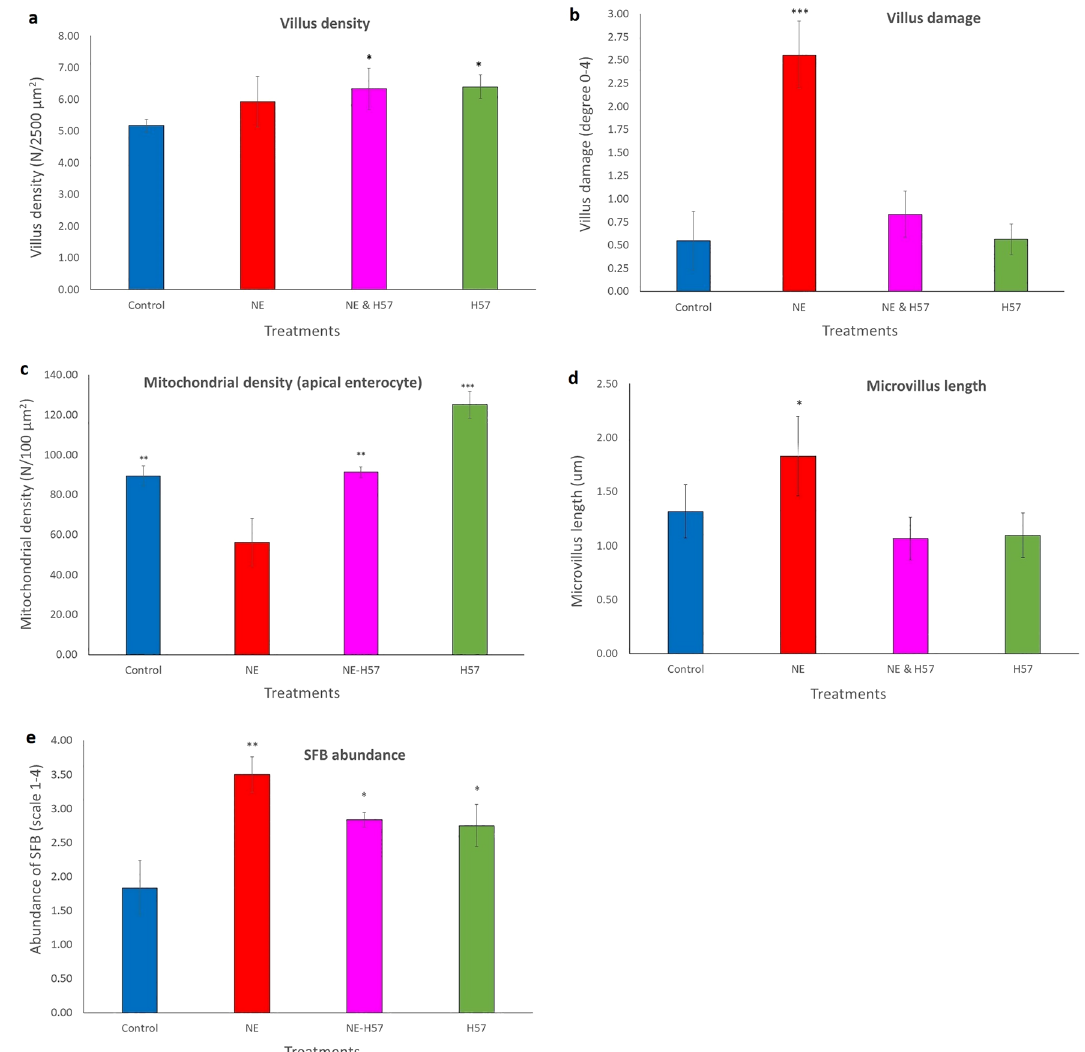
Figure 3. The effect of probiotic H57 on the villus density ( a ) and damage ( b ), SFB abundance ( c ), mitochondrial enterocyte density ( d ), and microvillus length ( e ) from 21 d old chicks exposed to necrotic enteritis. Control chicks were fed a basal diet (not supplemented with the probiotic H57) and not treated with any pathogen; NE chicks received a co-infection with Eimeria vaccine and Clostridium perfringens ( Cp ) and were fed a basal diet not supplemented with the probiotic H57; NE & H57 chicks were exposed to Eimeria vaccine and Cp , and fed a basal diet supplemented with the probiotic H57; H57 chicks were not treated with any pathogen, but fed the control diet supplemented with the probiotic. Error bars indicate SD, while asterisk indicates statistical significance (* p < 0.05; ** p < 0.01; *** p <